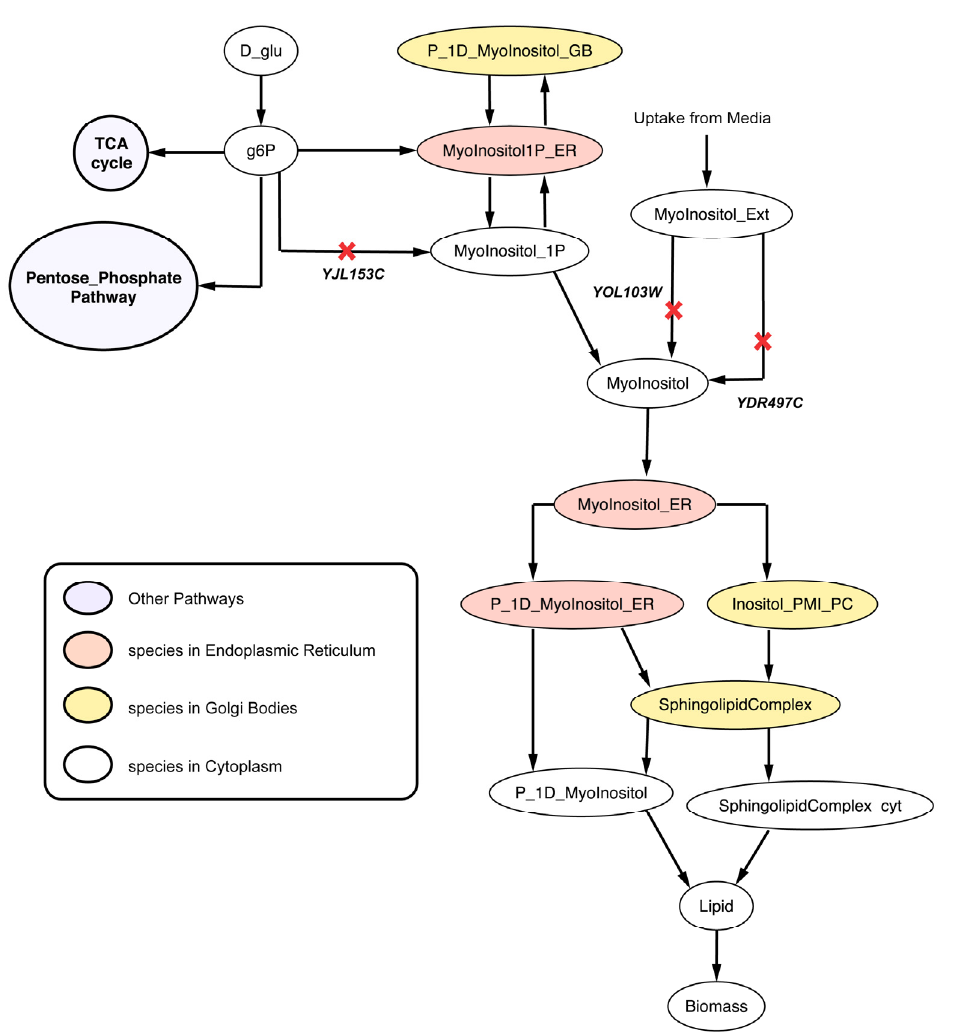
Figure 10. Lipid metabolism disrupted due deletion of synthetic lethal gene triplet. YDR497C and YOL103W are isozymes coding for the protein catalyzing the myo-inositol transport into the cytosol from media. Reactions catalyzed by SL gene triplet are marked with red